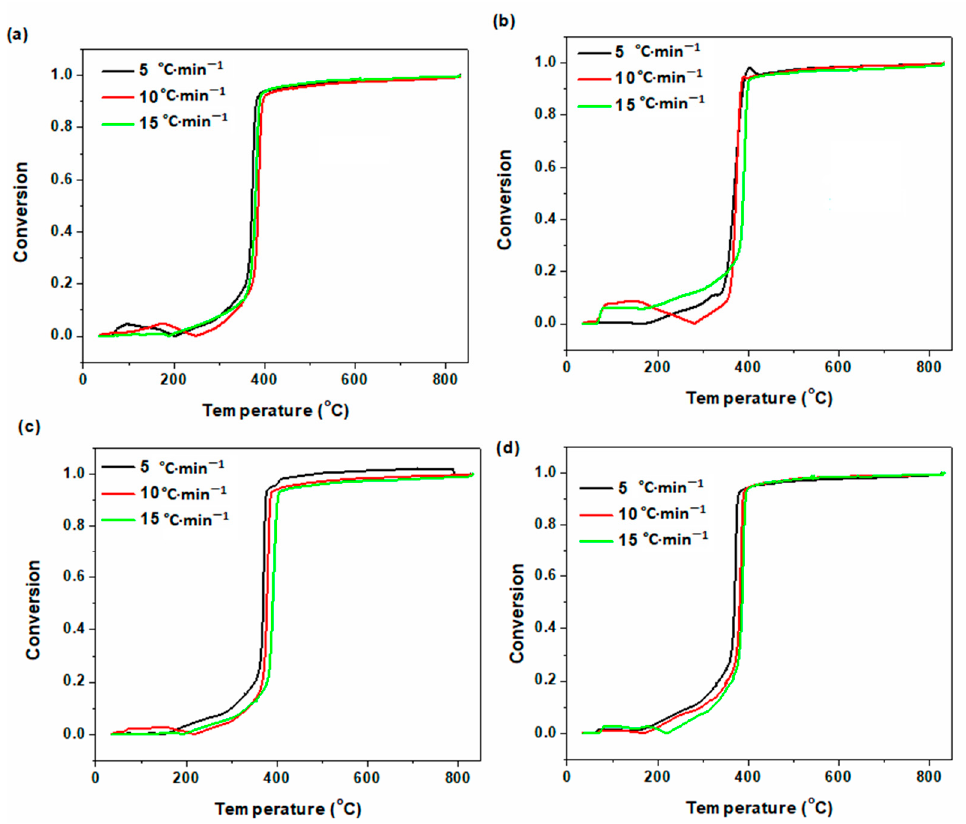
Figure 4. Degradation conversion profiles at various heating rates for ( a ) blank PU, ( b ) PU / V-ZrO 2 -1, ( c ) PU / V-ZrO 2 -3 and ( d ) PU / V-ZrO 2